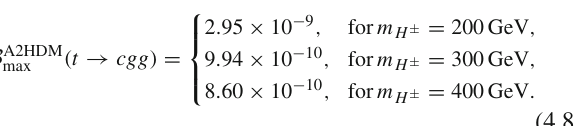
ment parameters ς u , d from a global fit obtained at the 95 . 5% CL in Ref. [75]. The thickness of the shaded regions reflects the corresponding allowed range for ς d ( u ) for a given value of ς u ( d ) , as can be read from the brown region of the left plot of Figure 9 in Ref. [75]